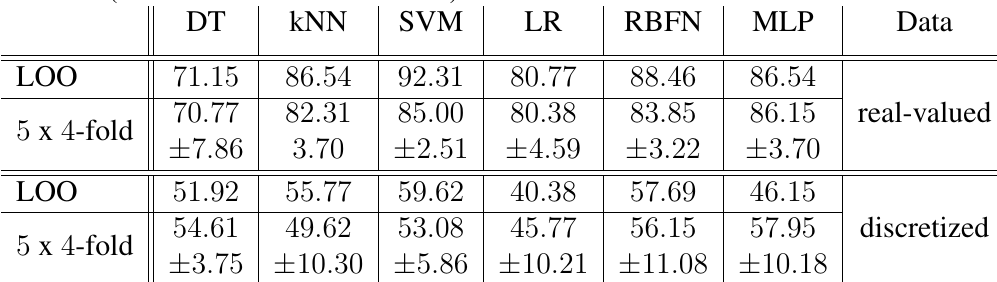
Table 2: Prediction accuracies obtained from standard classifiers using the real-valued dataset (Top) and a discretized version (Bottom), when LOO (Leave-One-Out) and 5 x 4-fold cross vali- dation are used. We use the following abbreviations: DT (Decision Tree), kNN (k-Nearest Neigh- bors), SVM (Support Vector Machines), LR (Logistic Regression), MLP (Multilayer Perceptron) and RBFN (Radial Basis Function